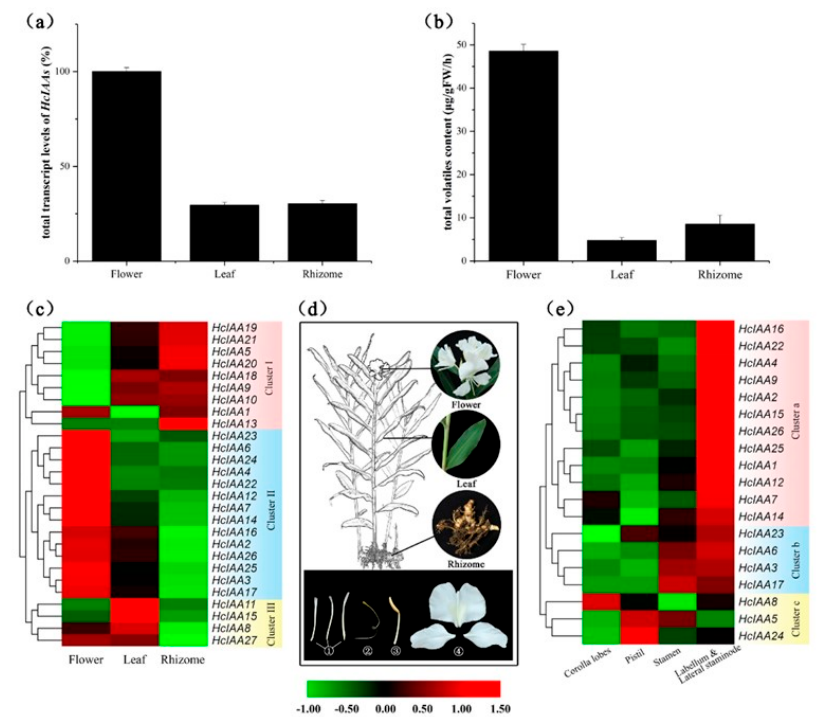
Figure 5. Expression profiles of HcIAA genes in various organs and tissues. ( a ) Total transcript levels of HcIAAs in flower, leaf and rhizome. ( b ) The total volatile contents in flower, leaf and rhizome. ( c ) Changes in the expression levels in three organs (flower, leaf and rhizome), which are schematically depicted above the displayed qRT-PCR data, are relative to RNA accumulation levels. Levels of downregulated expression (green) and upregulated expression (red) are shown on a log 2 scale from the highest to the lowest expression for each HcIAA gene. ( d ) Pictorial view of different organs/tissues ((1) corolla lobes, (2) pistil, (3) stamen, (4) labellum and lateral staminode) of H. coronarium. ( e ) Changes in the expression levels in different parts of the flowers for 19 HcIAA genes, which are schematically depicted above the displayed qRT-PCR data, are relative to RNA accumulation levels. Levels of downregulated expression (green) or upregulated expression (red) are shown on a log 2 scale from the highest to the lowest expression for each HcIAA gene.